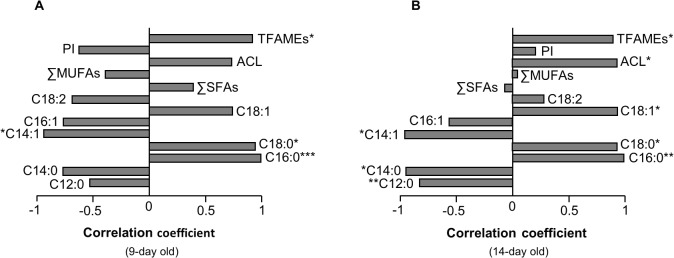
PCA loading plots assessing the effect of longevity selection on storage lipid composition.The fatty acid profiles of longevity-selected individuals were significantly different from control lines at 9 (P = 0.02; A) and 14 (P = 0.007; B) days of age. The loading plots represent the pattern of longevity selection-dependent alterations in eight neutral lipid fatty acid profiles and related (un)saturation indices along the PC1 axis. *P < 0.05, **P < 0.001, ***P < 0.0001.